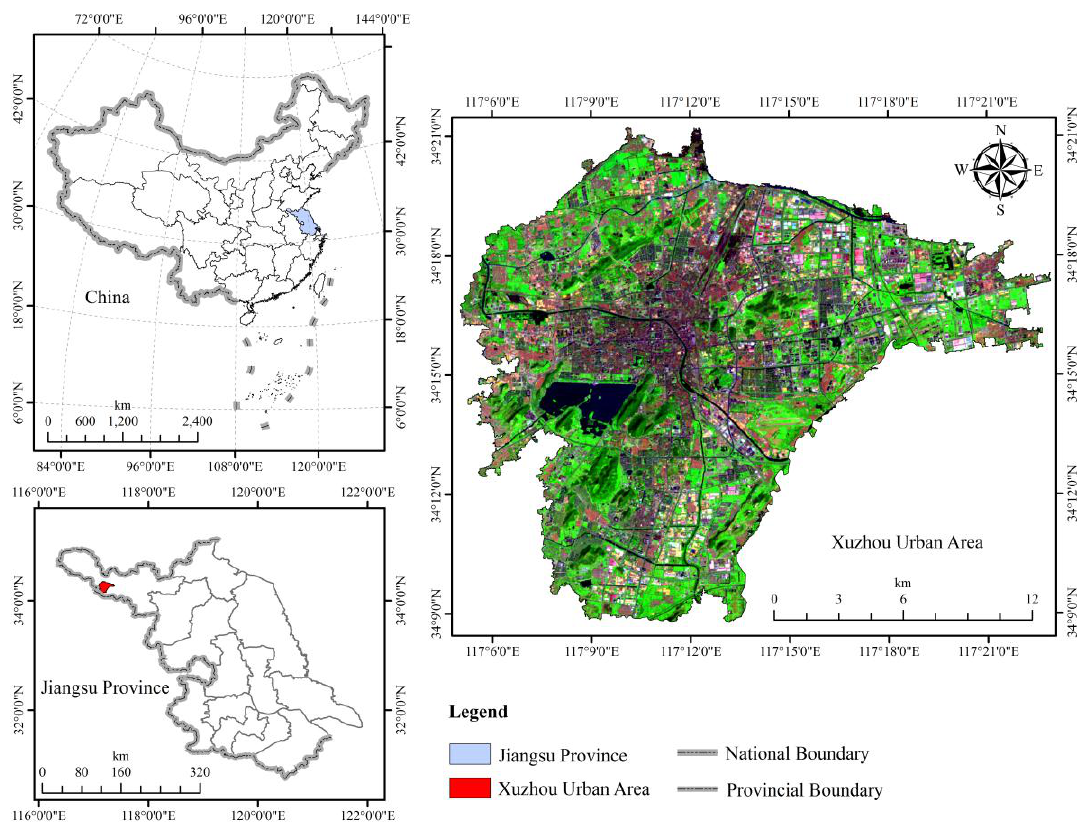
Figure 1. Location of Jiangsu in China, location of the Xuzhou urban area in Jiangsu, and location of the border of the Xuzhou urban area.